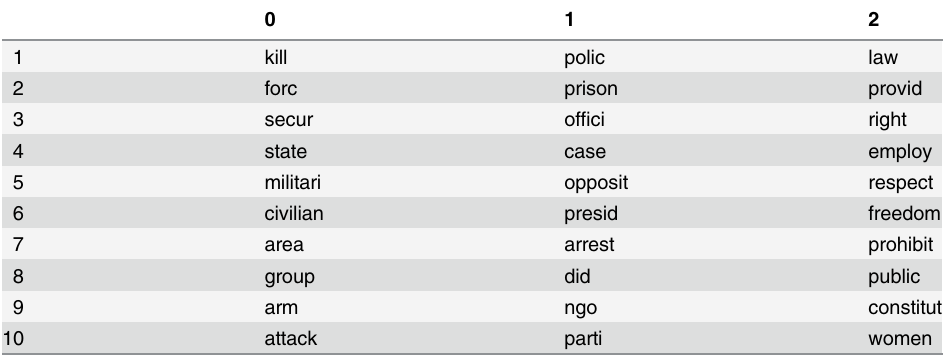
Table 3. Ten most important words for the CIRI Extrajudicial Killing